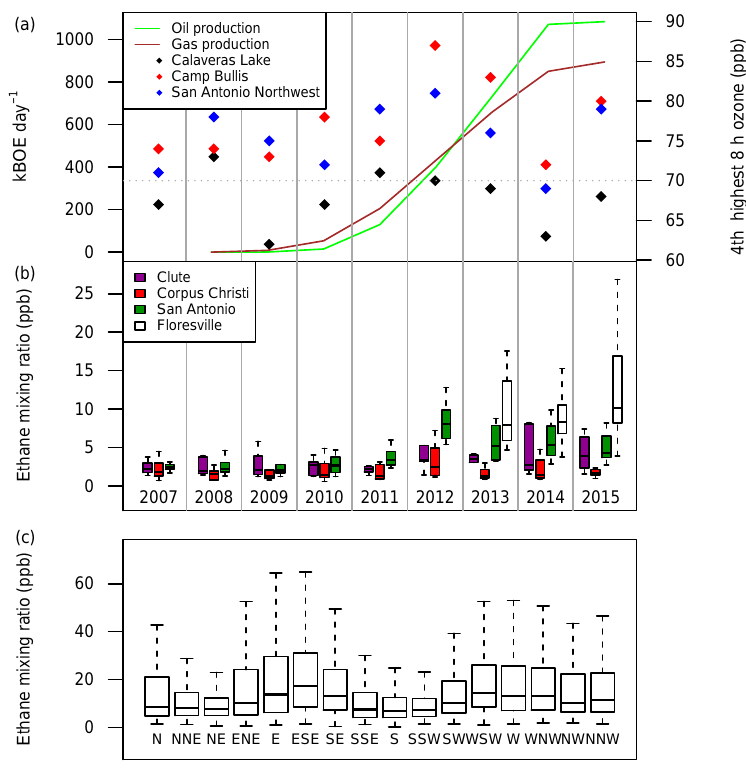
Figure 2. Adapted version of Fig. 2 in Schade and Roest (2015), updated to include data through 2015. (a) Oil and gas production rates in the Eagle Ford and fourth-highest maximum 8h ozone values at three sites in San Antonio. (b) Timeline of 24h ethane mixing ratios at four sites near the Eagle Ford Shale. Days were used only if three out of four back trajectories originating from San Antonio – Old Highway 90 were binned as southeasterly. Data at Floresville begin in July 2013. (c) Ethane mixing ratios vs. wind direction at Floresville, with elevated mixing ratios under E to SE or SW to W winds, when trajectories would generally allow for the accumulation of emissions because winds have a component that is parallel to the shale axis. Ethane is also elevated under NW winds, likely due to higher ethane in continental air masses and local emissions from the San Antonio metropolitan